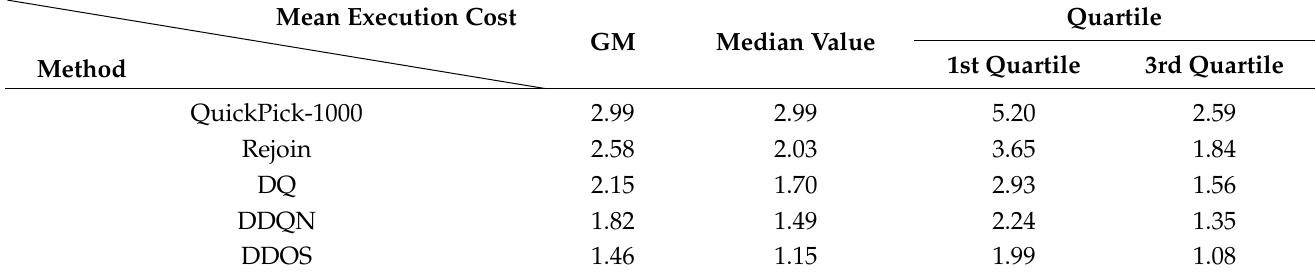
Table 1. Relative execution cost statistics of DDOS, DDQN, DQ, Rejoin, and QuickPick-1000.